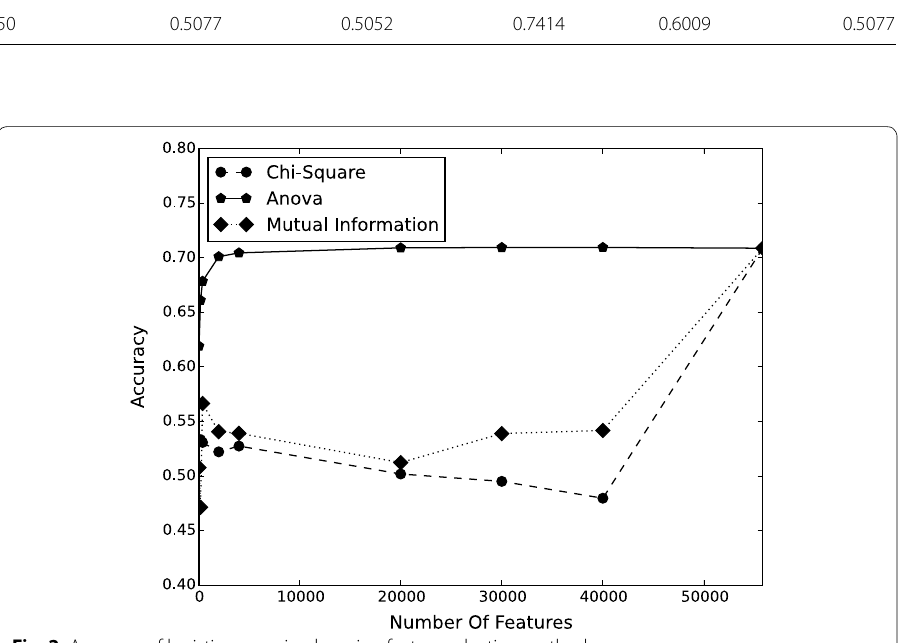
Fig. 2 Accuracy of logistic regression by using feature selection